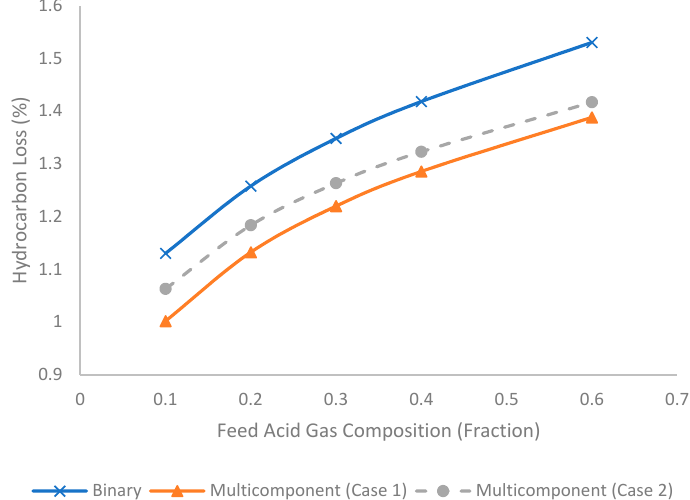
Figure 14. Evolution of hydrocarbon loss (%) under different acid gas composition (fraction) for binary and multicomponent systems.